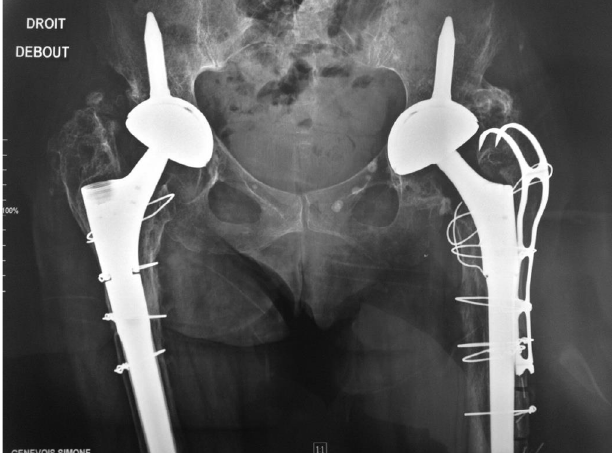
Figure 6. Bilateral bipolar revision. ETO fi xed by metallic wires (right) and MRP Integra (left), complete healing of the osteotomised fragment at 1 year on both